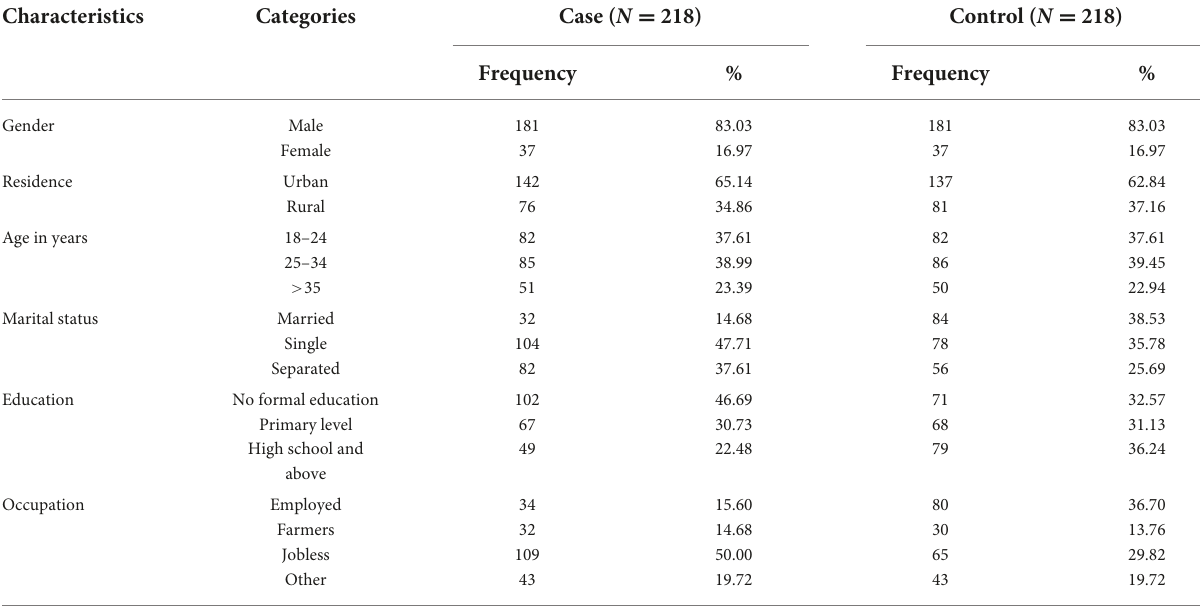
TABLE 1 Socio-demographic characteristics of the study participants at selected public hospitals in eastern Ethiopia from December 1, 2021 to January 30, 2022.